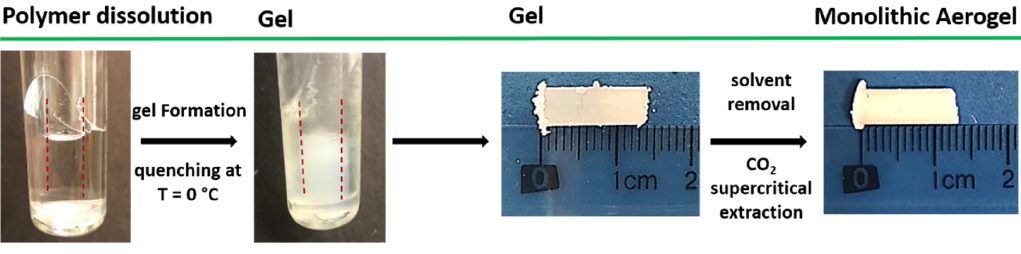
Figure 1. PLLA monolithic aerogel preparation procedure. PLLA dissolution temperature: 130 and 180 °C, with CPO and BzOMe solvent, respectively. Solvent extraction conditions: T = 40 °C and p = 250 bar, extraction time = 180 and 240 min, for PLLA/CPO and PLLA/BzOMe gel, respectively.